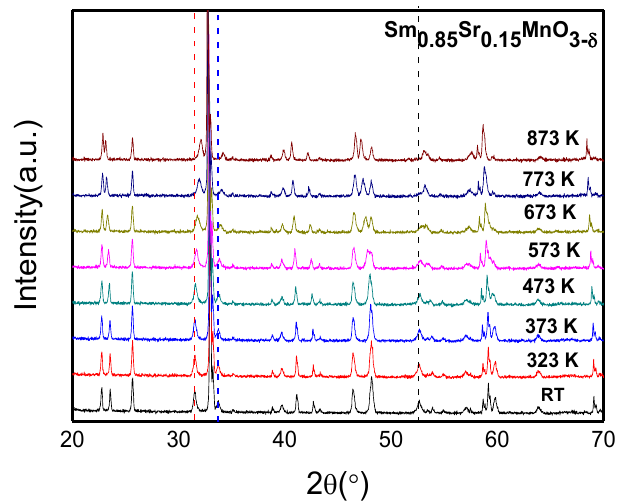
Figure 4. XRD patterns of Sm 0.85 Sr 0.15 MnO 3- δ ceramics at high temperatures.